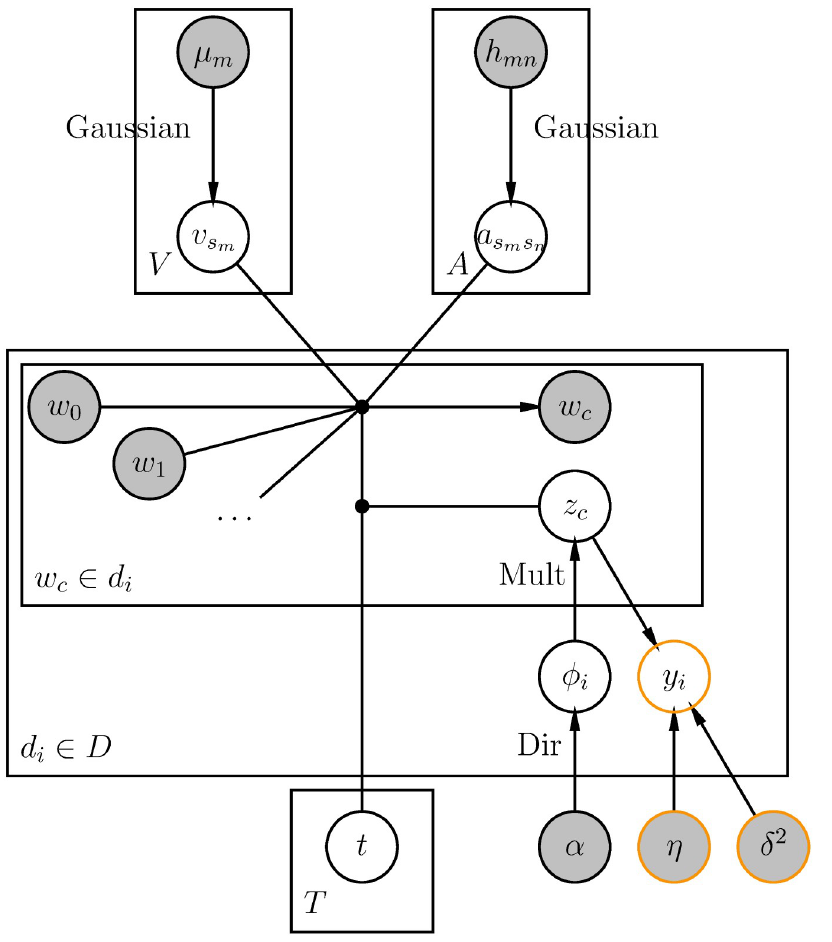
Fig 2. Graphical model of